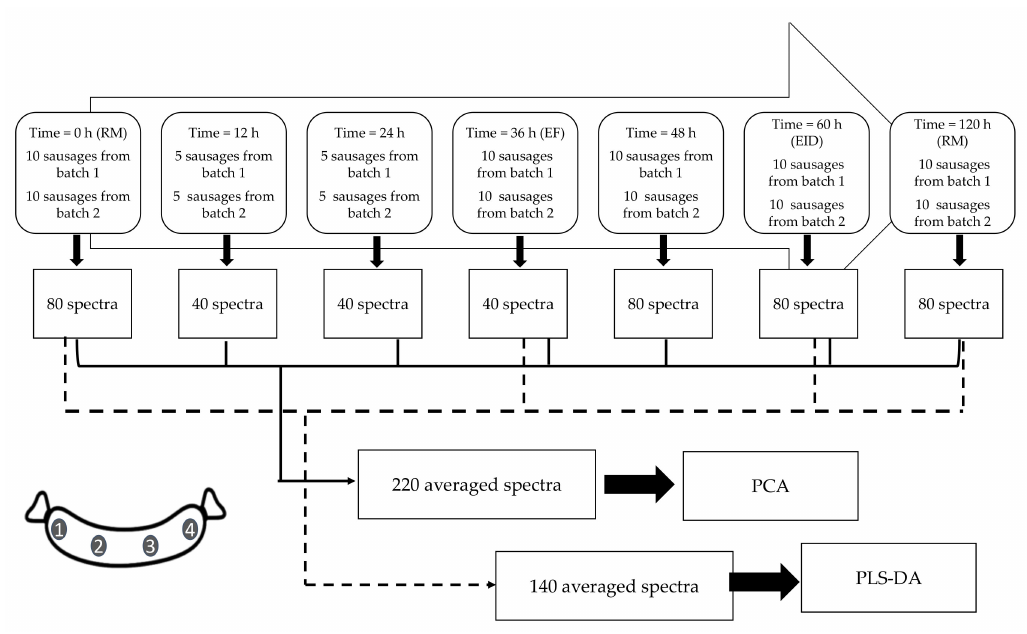
Figure 2. Scheme of the spectra acquisition procedure. RM, raw material; EF, the end of fermentation; end the intense drying (EID); FP, final product stages; PCA, Principal Component Analysis; and PLS-DA, Partial Least Square-Discriminant